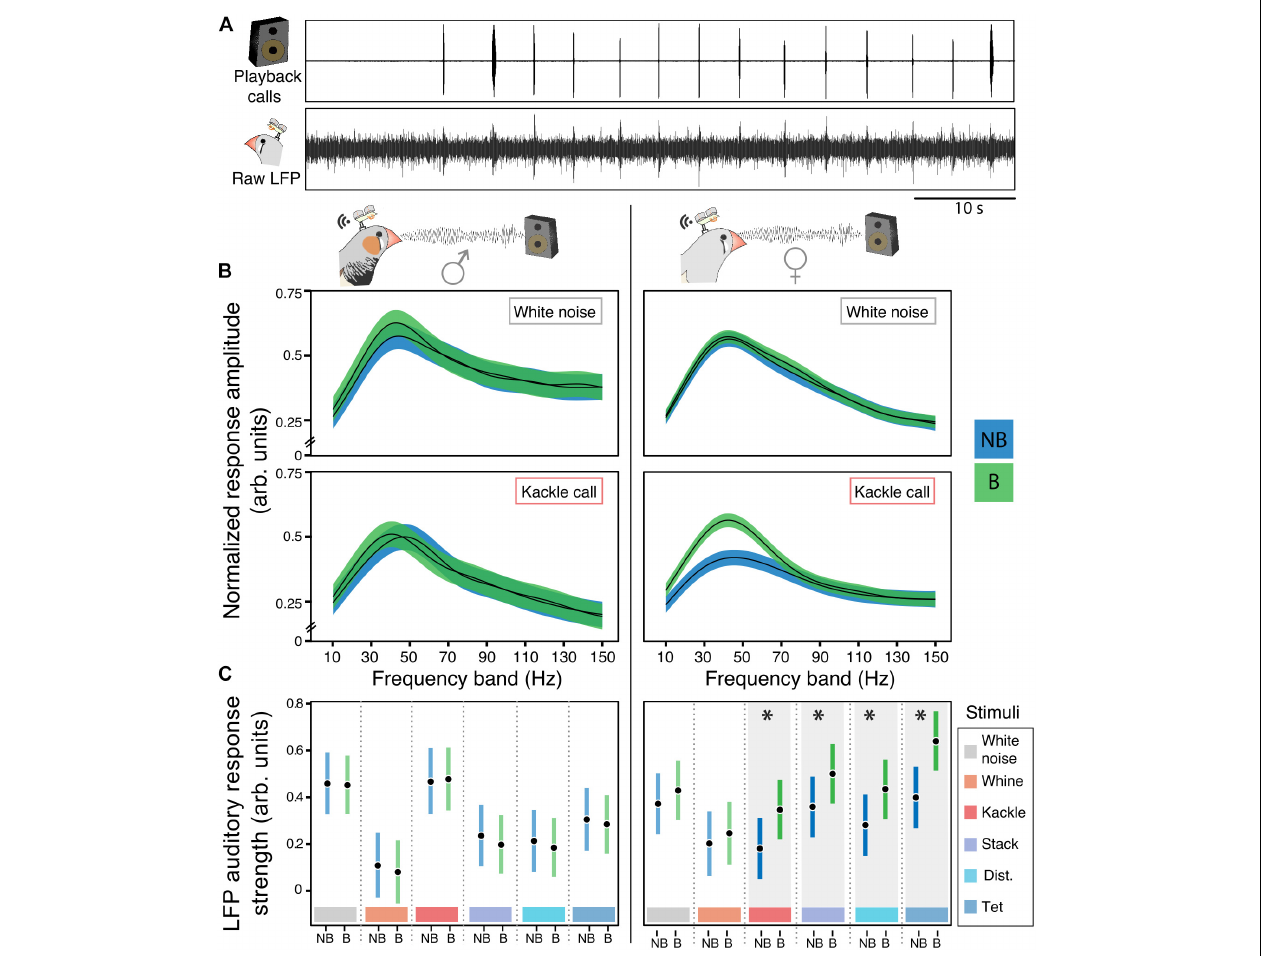
FIGURE 4 | Females’ auditory responses toward night playbacks change selectively after the breeding onset. (A) Example of NCMs’ LFP responses toward playbacks. Raw LFP corresponds to the 300 Hz threshold low pass filtered response in NCM. (B) Males’ (left) and females’ (right) auditory LFP response amplitude in non-breeding (NB) and breeding (B) contexts in response to white noise and kackle breeding calls during playback. Black lines represent the mean and colored ribbons the 95% confidence intervals of the general additive mixed models. (C) Males’ (left) and females’ (right) estimated mean and 95% CrI for the NCM ARS in the 30–50 Hz band toward different playback stimuli in non-breeding (NB) and breeding (B) life stages. There is an effect (indicated by asterisks) of the breeding onset in females LFP response to kackle calls (posterior probability difference between NB and B = 99.83%), to stack calls (posterior probability difference between NB and B = 98.78%), distance calls (posterior probability difference between NB and B = 98.79%) and tet calls (posterior probability difference between NB and B higher than 99.99%)